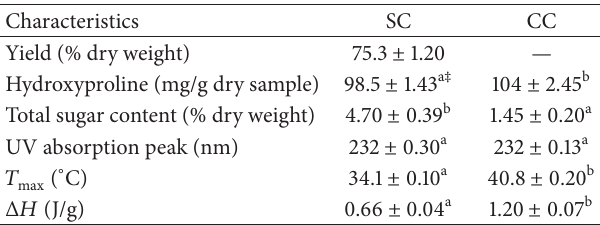
Table 1: Yield and characteristics of collagen from the skin of splendid squid (SC) and type I collagen from calf skin (CC) † .